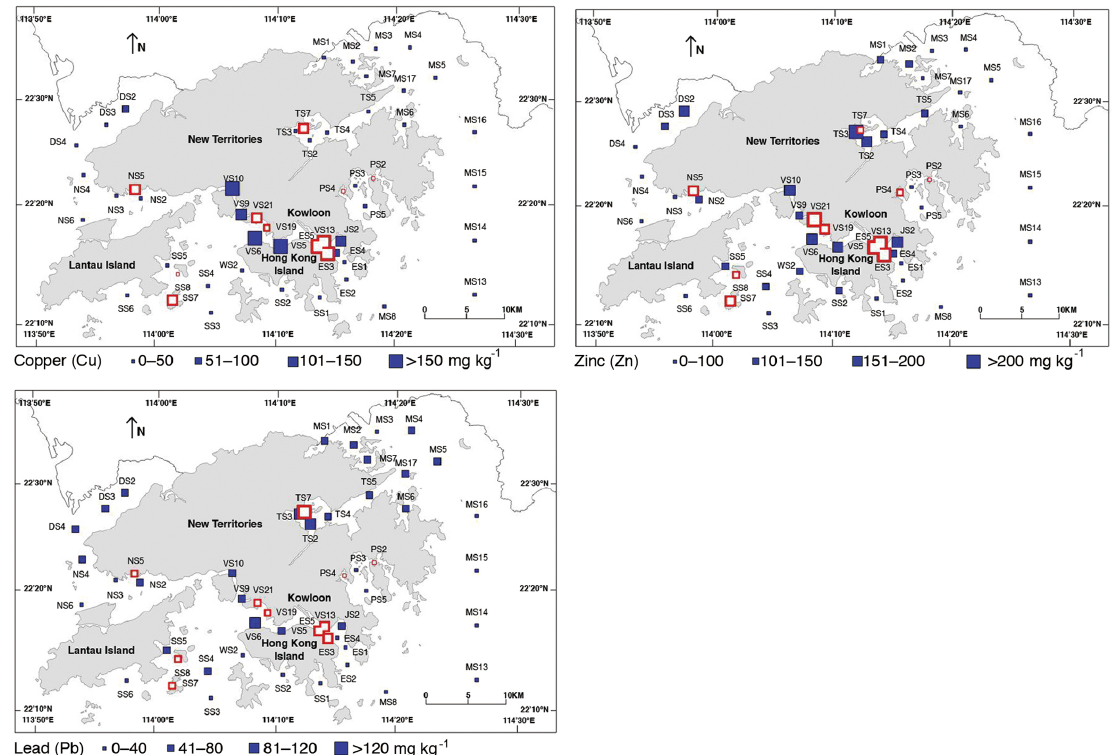
Figure 3. Spatial distribution of environmental parameters in Hong Kong. Mean copper (Cu) concentration, mean lead (Pb) concentration, and mean zinc (Zn) concentration in surface sediments. All are averaged values of the data obtained during 1986–2013 (Table